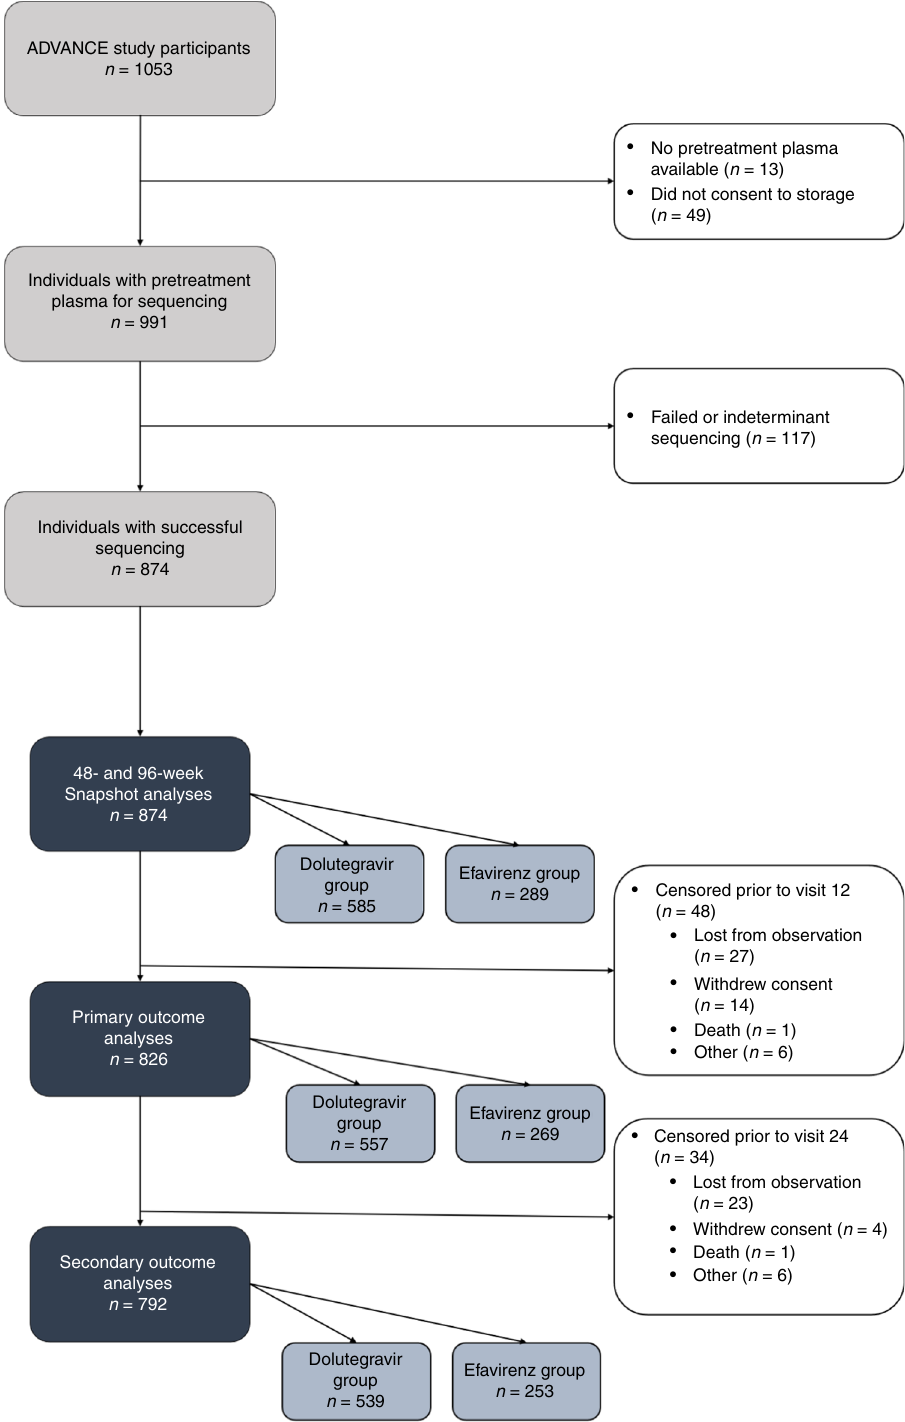
Fig. 1 Study schema. Study schema showing numbers of participants with plasma samples, successful sequencing and numbers in primary and secondary